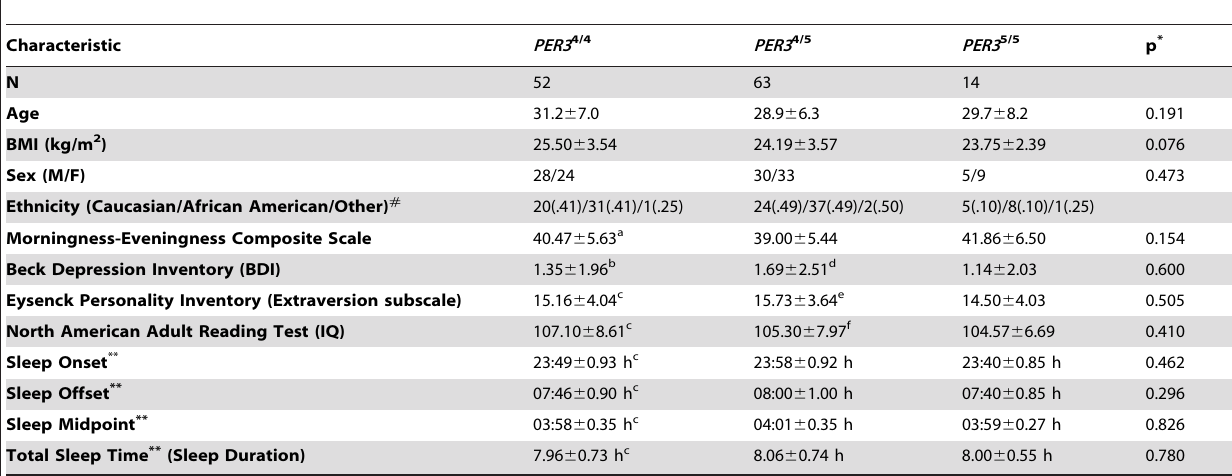
Table 1. Characteristics of PER3 4/4 , PER3 4/5 and PER3 5/5 Subjects (Mean 6